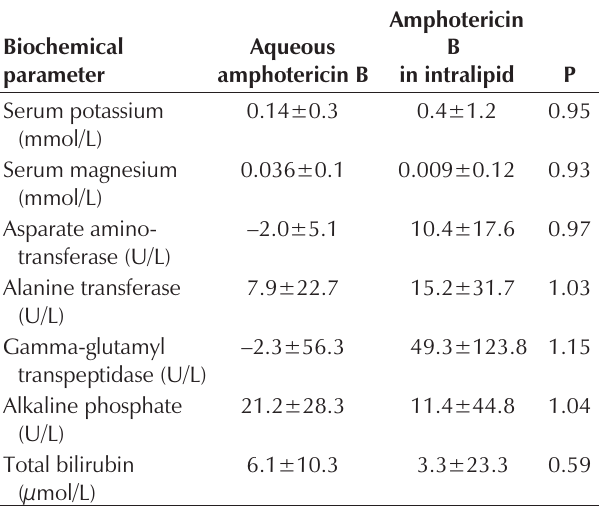
Table 1 details the characteristics of the patients. Six patients